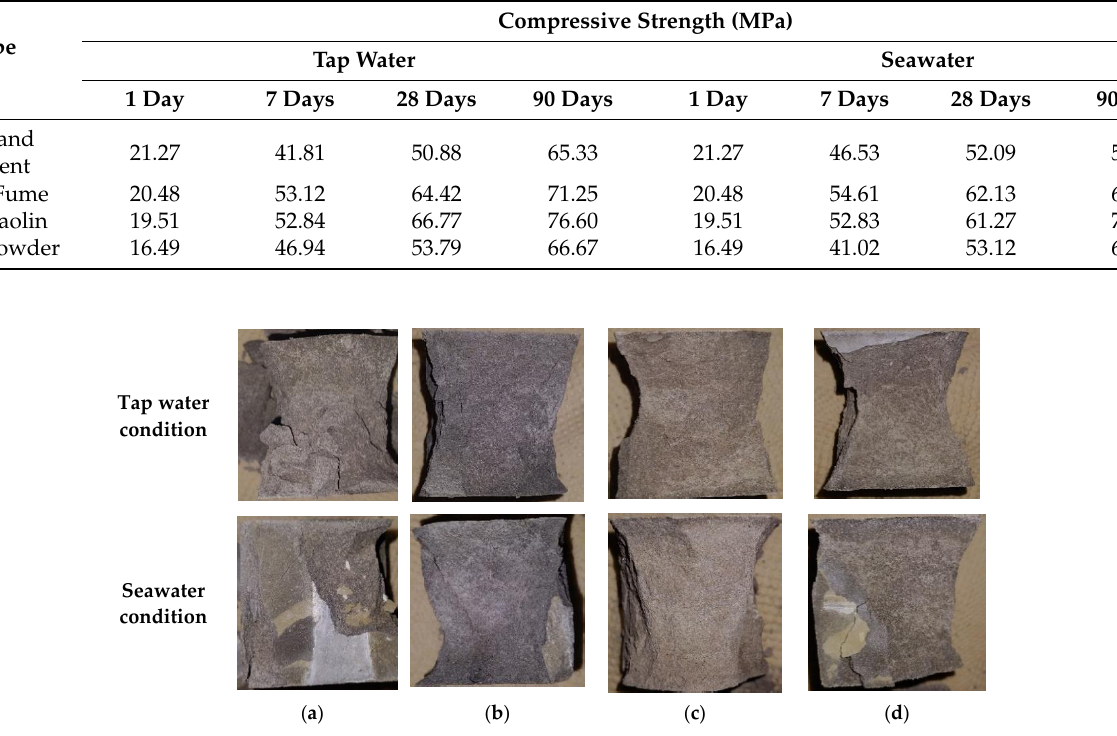
Figure 6. Representative failure modes of samples after 28 days compressive strength measurement: ( a ) neat PC; ( b ) PCM containing silica fume; ( c ) PCM containing metakaolin; ( d ) PCM containing class powder.